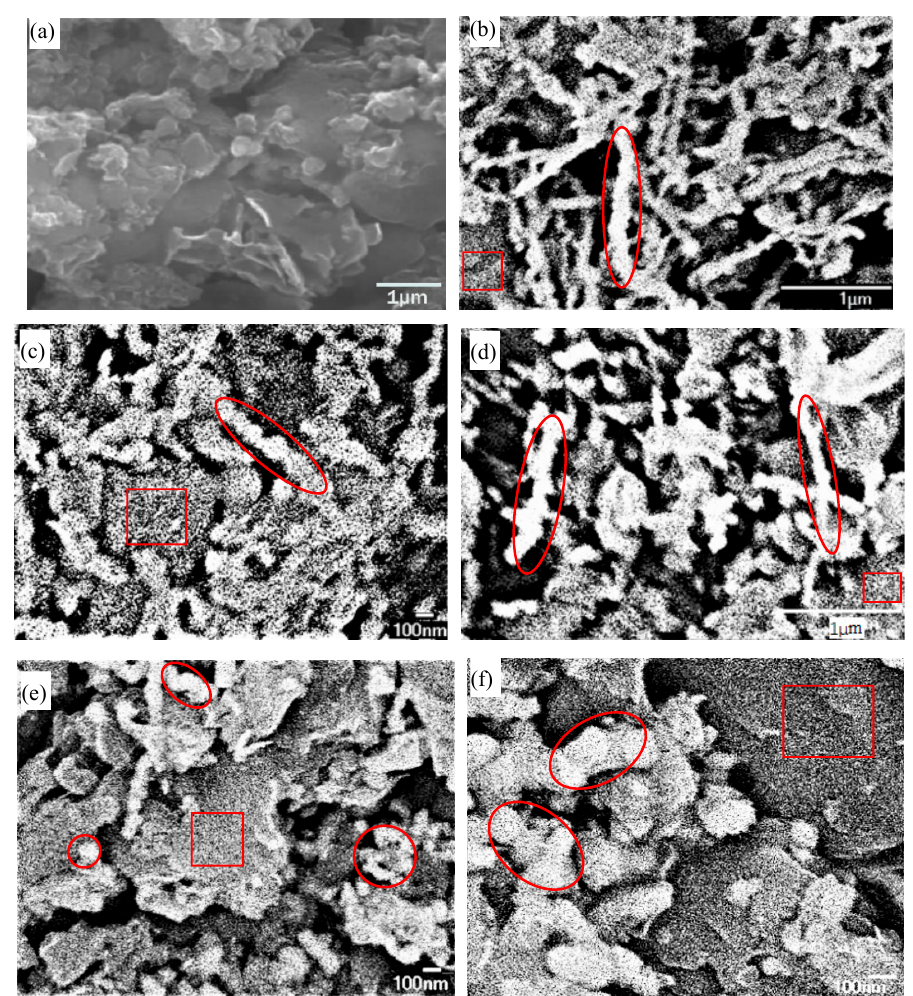
Figure 1. SEM images of bentonite ( a ) and BFe 0 NPs with different bentonite contents ( b – f ): ( a ) bentonite; ( b ) 1%; ( c ) 2%; ( d ) 3%; ( e ) 4%; and ( f ) 5%. The white chain-like conformations and dispersed particles represent Fe 0 (circles/ovals), and the grey backgrounds represent bentonite (rectangles).